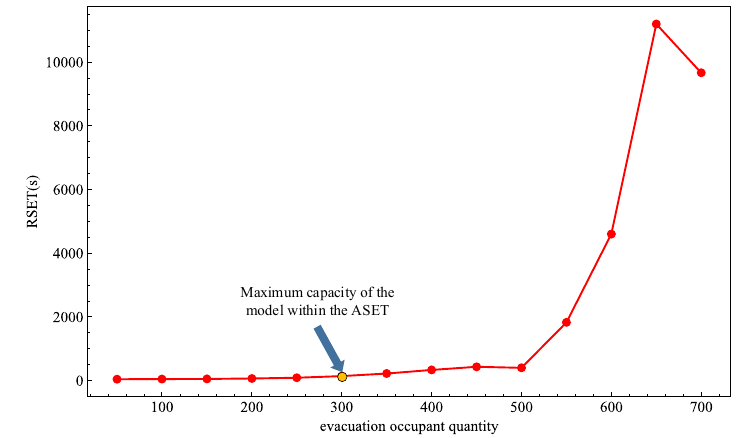
Figure 12. The relationship between RSET and the number of